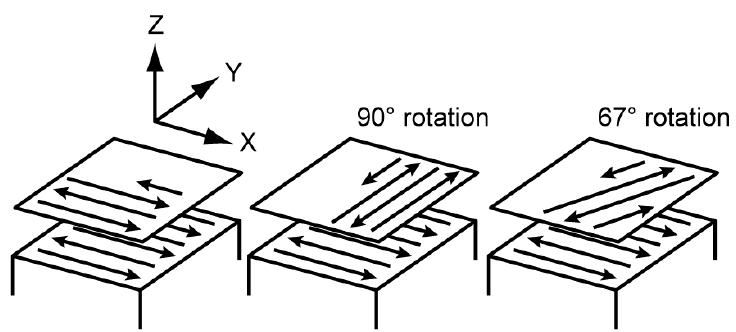
Figure 2. X-scan, XY-scan, and Rot-scan strategies.